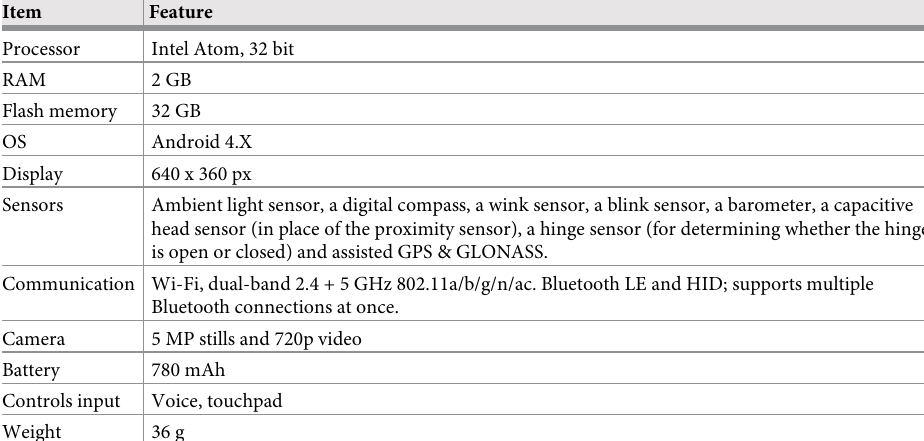
Table 2. Technical specifications for SG used in this